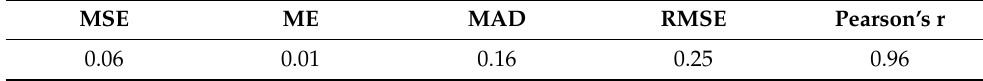
model. Table 6. Evaluation metrics of HbA1c for the reflection-type fingertip model.